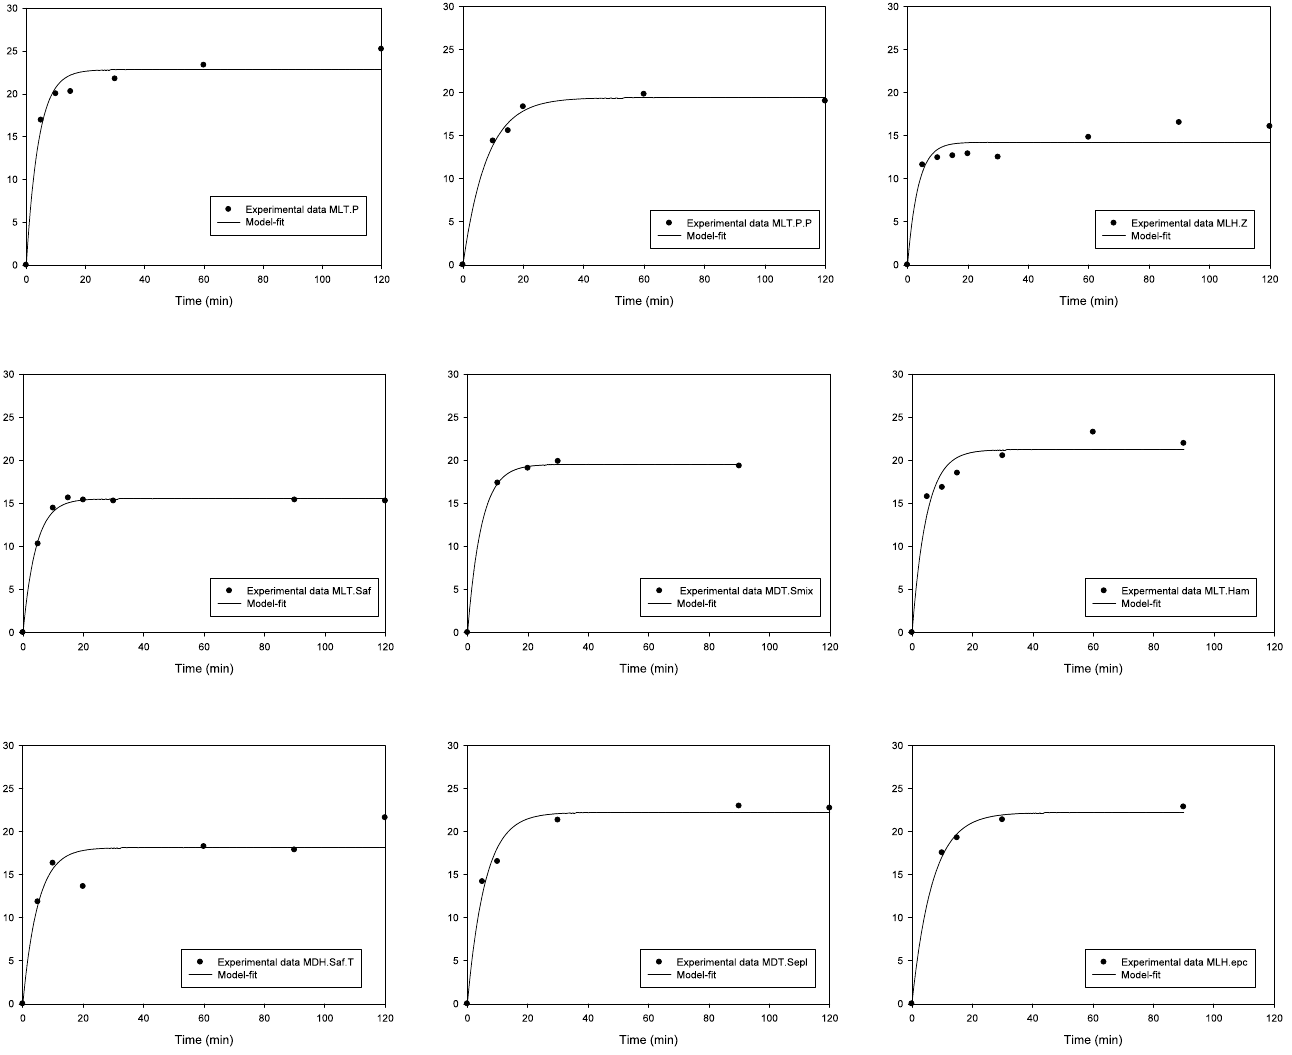
Fig. 1: Digestibility curves obtained for pearl millet flours. lyzed by amylases. The extent of the reaction indicates that these flours have a low susceptibility to digestion. Predicted values for variables affecting starch amylolysis (C ∞ and k), that were obtained from the first-order model, fit to the experimental